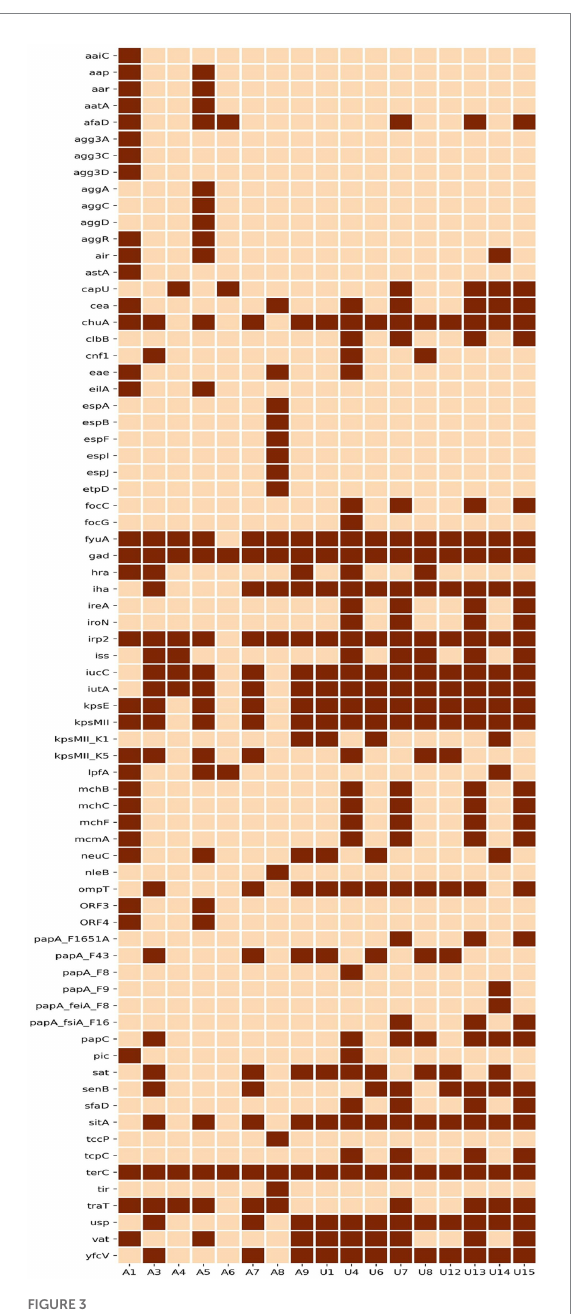
FIGURE 3 Heat map depicting the distribution of 73 virulence genes amongst 17 NLF E. coli genomes. Dark brown represents the presence, and light brown blocks represent a virulence gene’s absence.